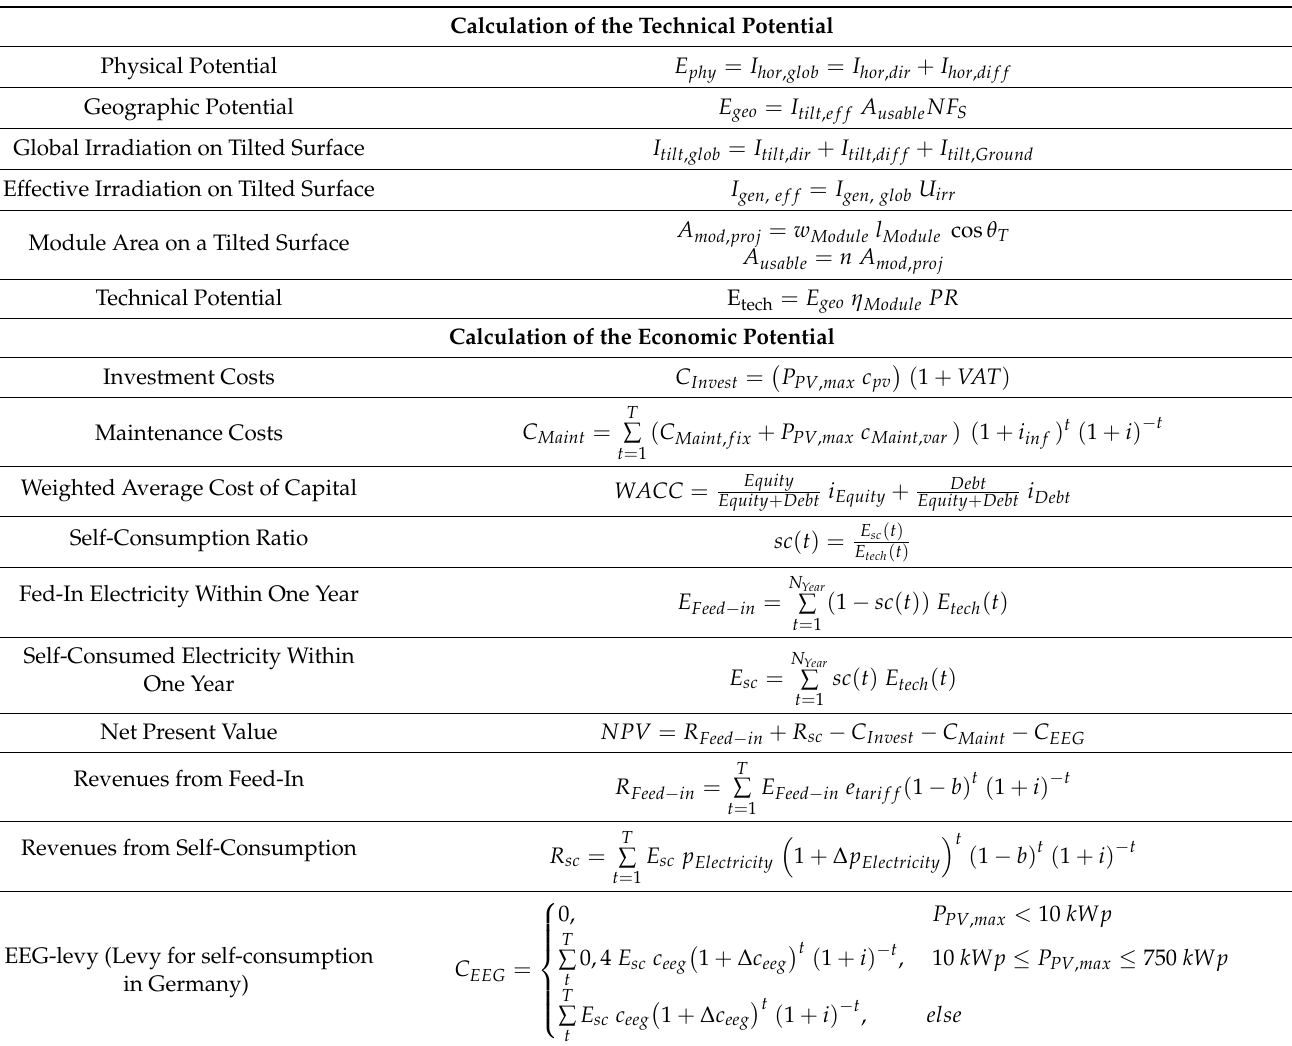
Table A1. Equations for technical and economic potential